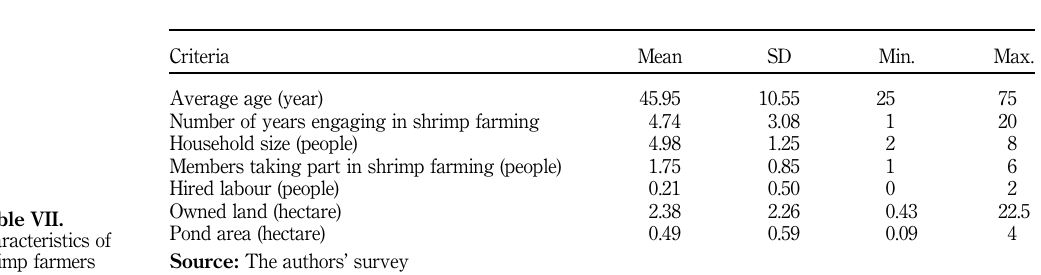
Table VI. Sample distribution by shrimp species and farming type